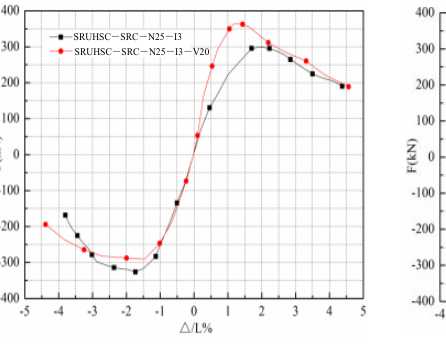
Table 4. Skeleton curve eigenvalue.